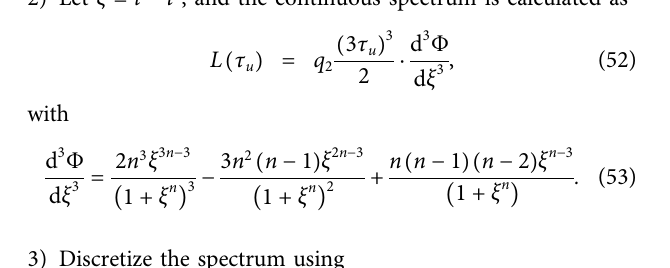
FIGURE3 | Layered system ofthe FEelementsand data fl ow in Abaqus with UEL and